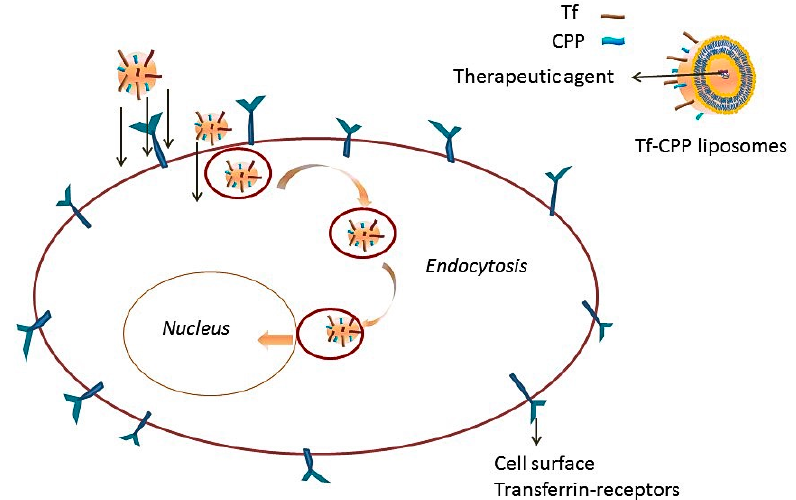
Figure 2. Uptake of liposomes by cells via a dual-mechanism involving receptor targeting and cell penetration.